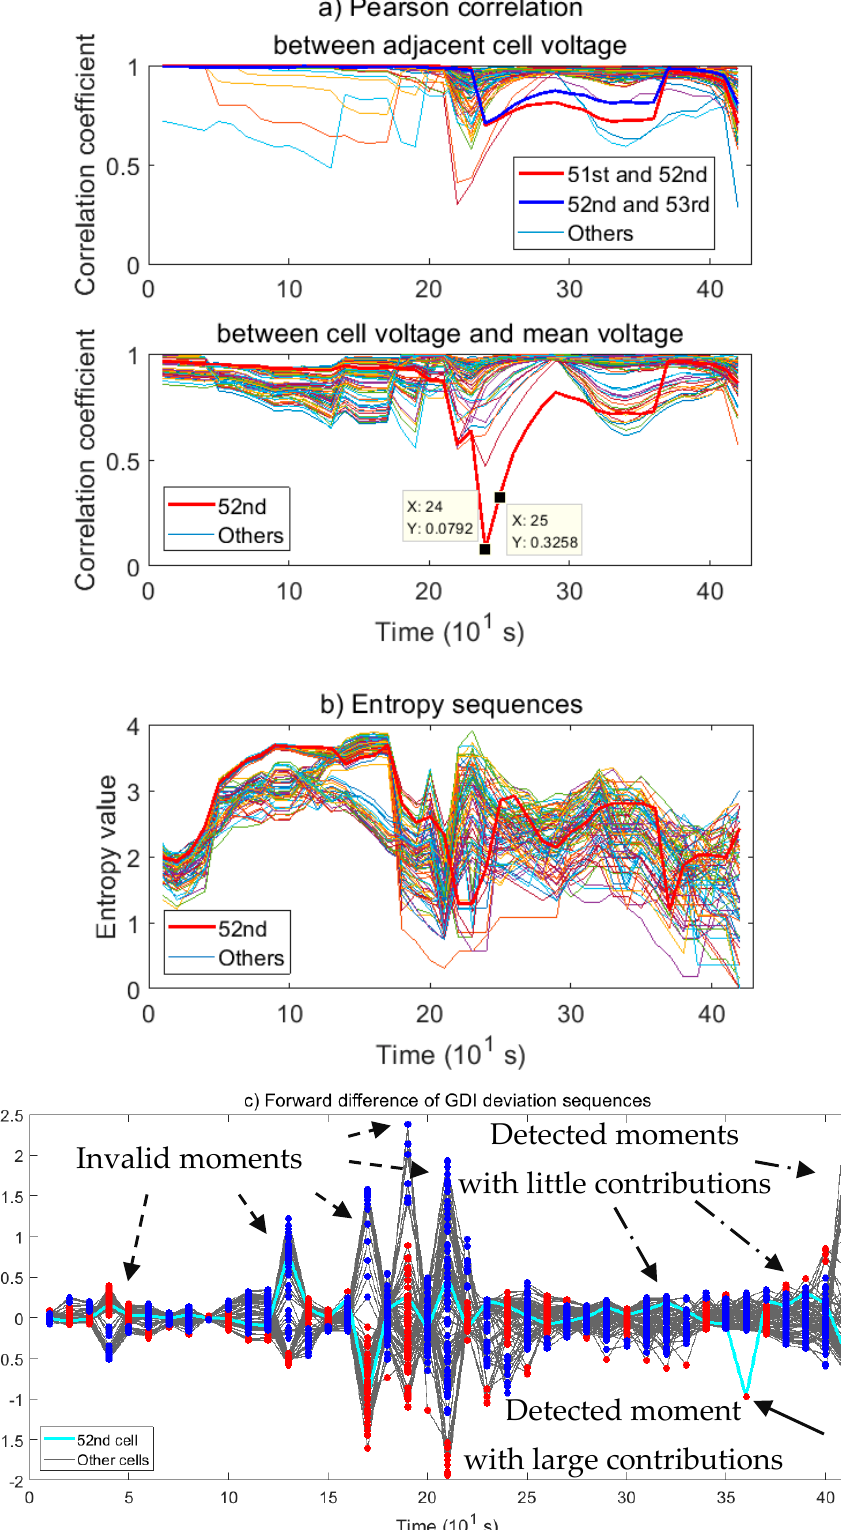
Figure 11. From the pre-fault dataset in the third case, ( a ) Sequences of the Pearson correlation coefficient; ( b ) Sequences of the entropy of normalized cell voltage data; ( c ) The forward difference of the GDI deviation sequences, with the points in different temporal clusters marked in red or